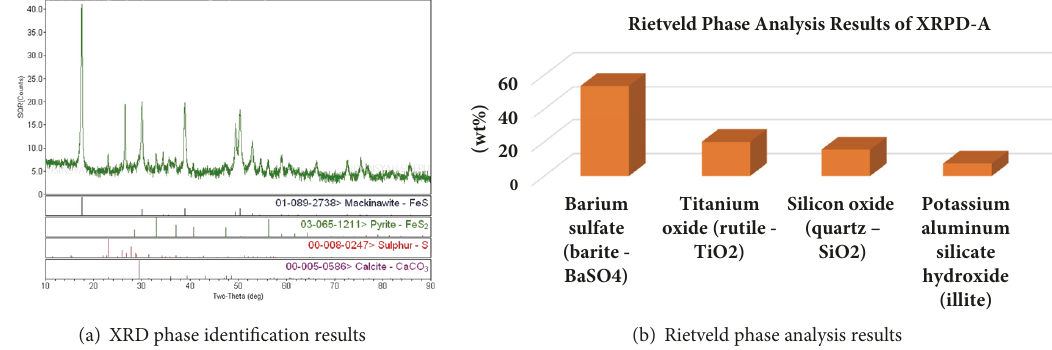
Figure 2: (a) XRD phase identification results of the inorganic deposits present in the sludge deposits (XRPD-A) along with the identified mineral reference patterns. (b) The wt% of the identified phases obtained from the Rietveld method.